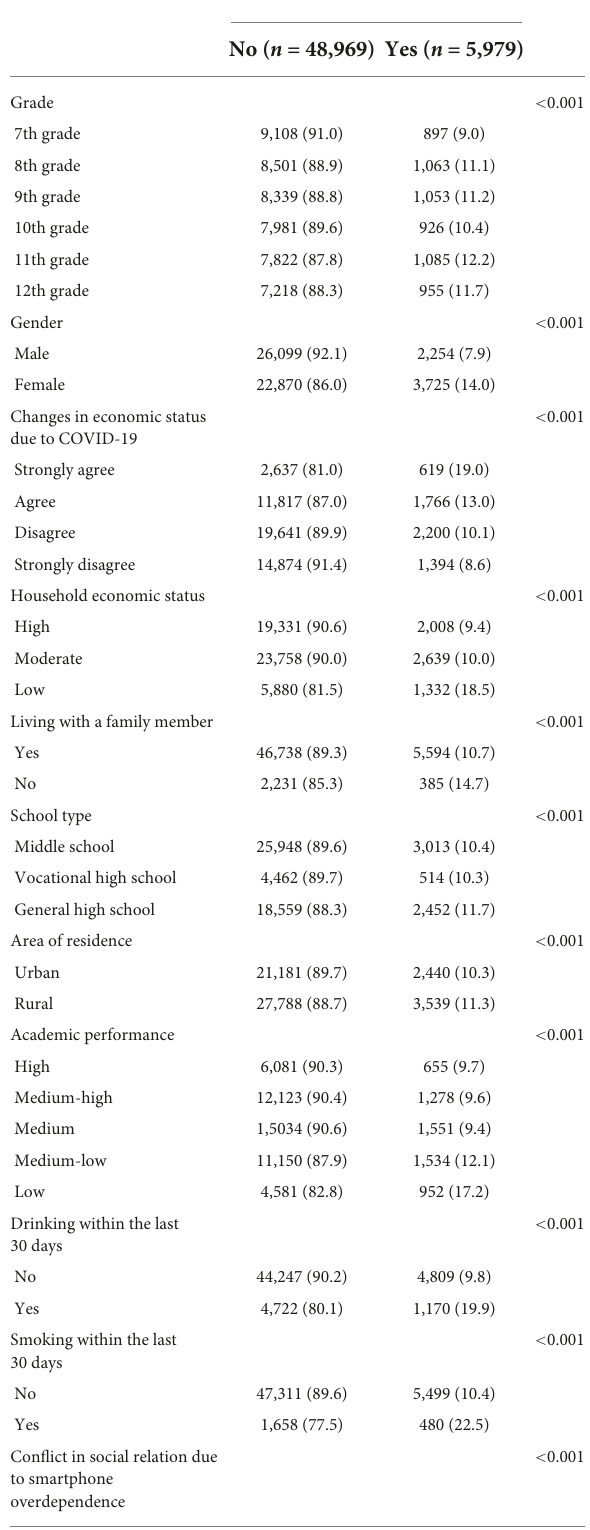
TABLE 1 General characteristics of subjects according to suicidal ideation, n